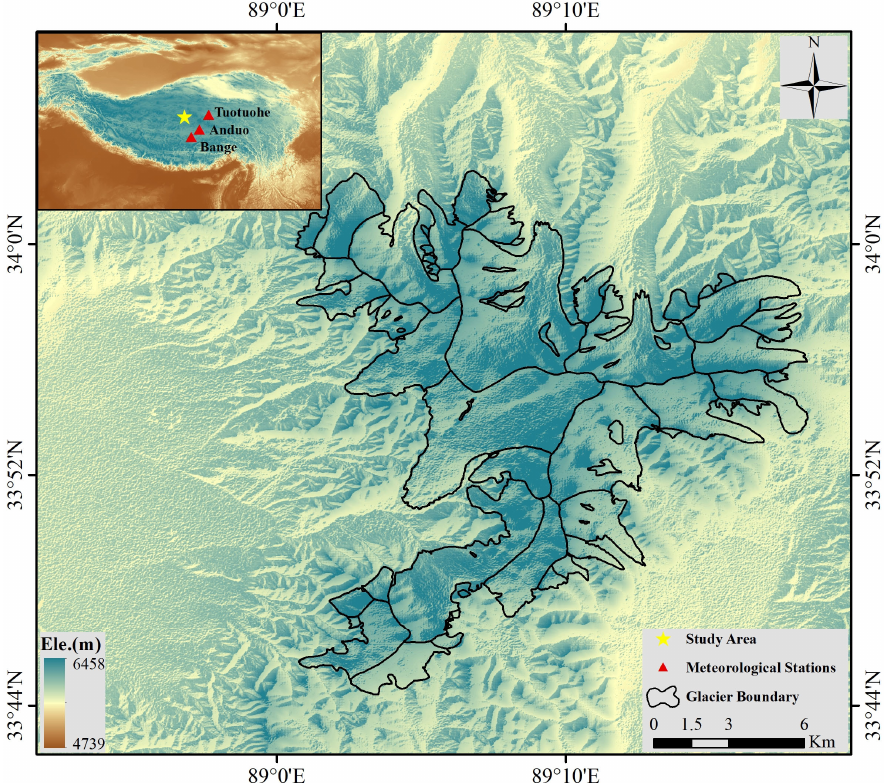
Figure 1. An overview of the Puruogangri Ice Field in the central part of the TP. The background is the SRTM DEM.